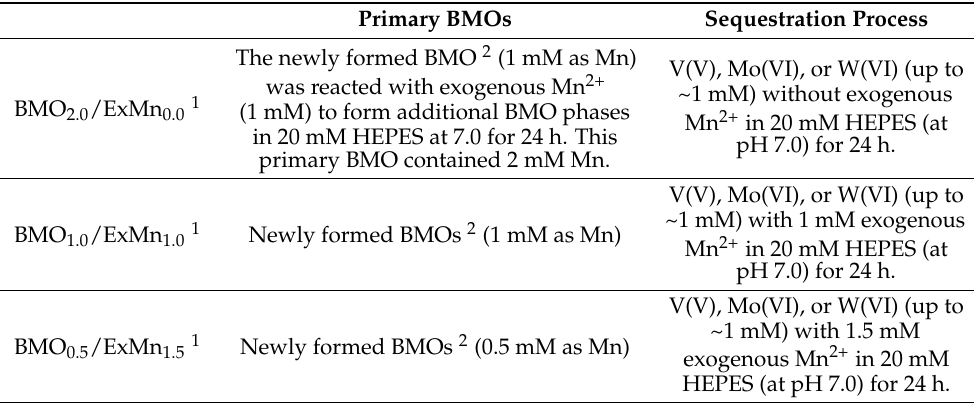
Table 1. Experimental conditions for sequestration experiments using newly formed BMOs with and without exogenous Mn 2+